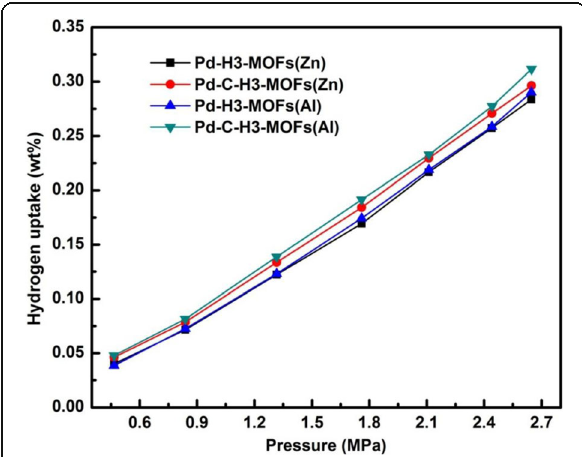
Fig. 7 Hydrogen adsorption isotherms of Pd-H3-MOFs(Zn), Pd-H3- MOFs(Al), Pd-C-H3-MOFs(Zn), and Pd-C-H3-MOFs(Al)